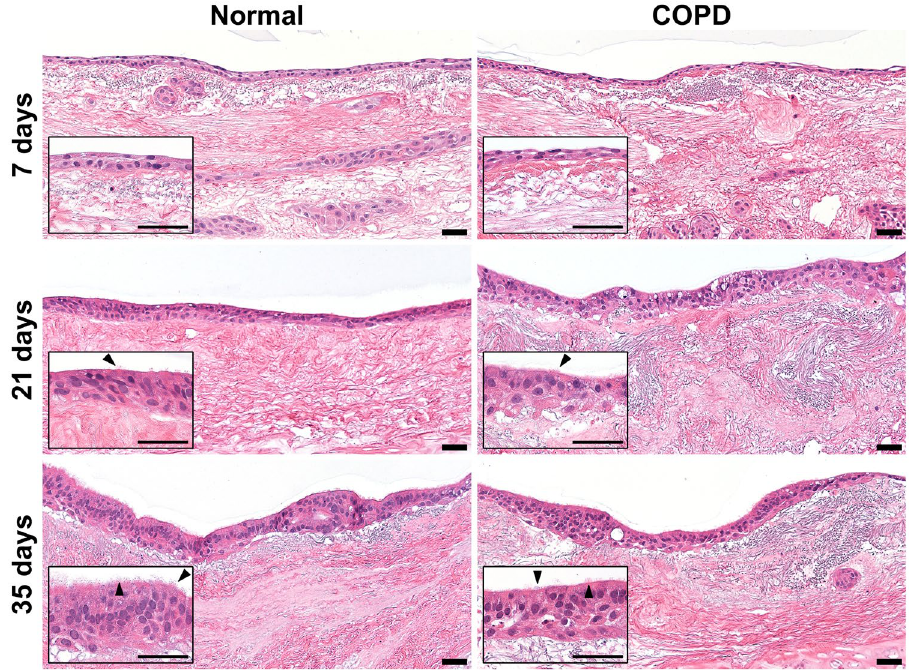
Figure 3. Primary normal human bronchial epithelial cells develop cilia and assume a pseudostratified morphology during differentiation on normal and COPD bronchial scaffolds. Hematoxylin & eosin staining showing the morphology of primary normal human bronchial epithelial cells differentiated on normal or COPD scaffolds for 7, 21 and 35 days. Insets show the same images at high magnification. Images are representative of n = 3. Arrows: cilia. Scale bars: 50 µ